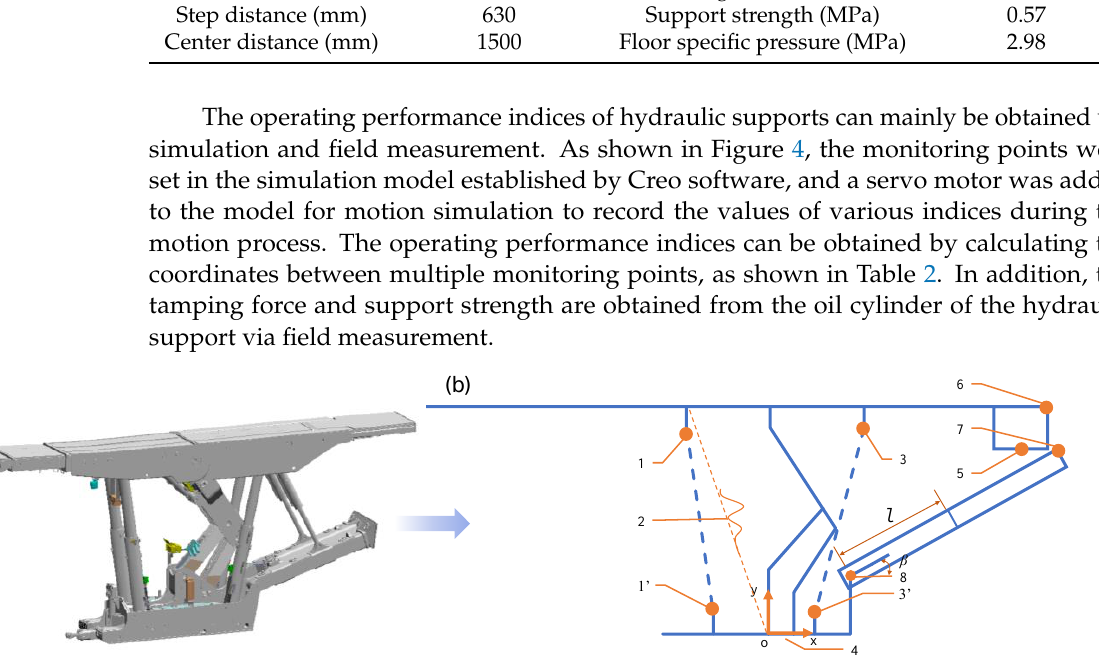
Figure 4. Simulation model of a four-column backfilling hydraulic support: ( a ) three-dimensional model; ( b ) skeleton model (1 , 1’— monitoring point of the front column; 2 — servo motor; 3 , 3’— monitoring point of the rear column; 4 — coordinate system for monitoring; 5 — monitoring point of the blanking port; 6 — monitoring point of the rear top beam; 7 — monitoring point of the tamping mechanism; 8 — the origin of the tamping mechanism; l — length of tamping mechanism when retracting; β —tamping Table 2. The statistical parameters for the dataset.